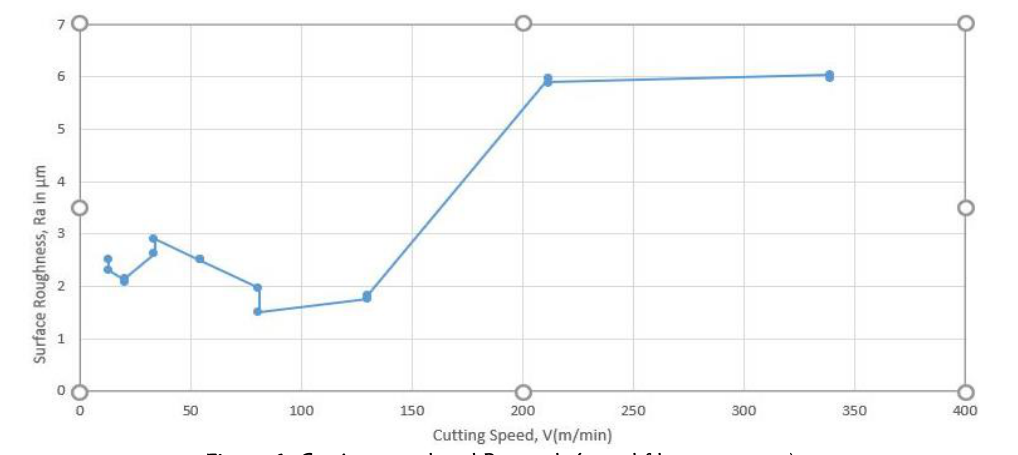
Figure 6: Cutting speed and R a graph (v and f kept constant)